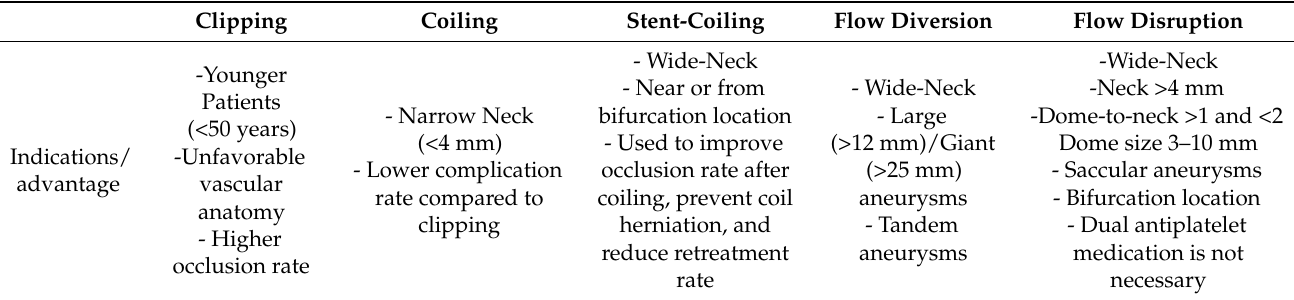
Table 1. Comparing treatment modalities of intracranial